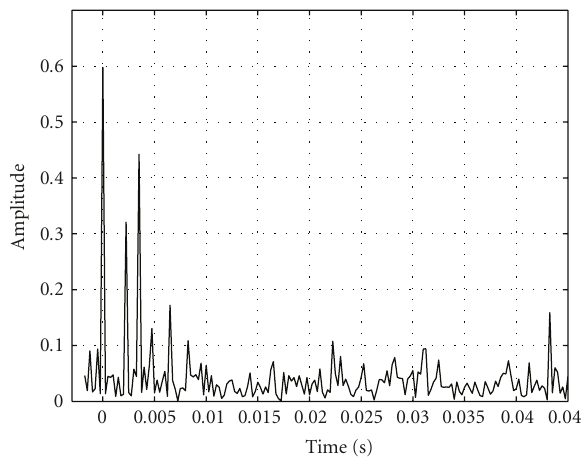
(a) Non − Gray mapped constella- (b) Gray mapped constellation tion Figure 4: QPSK constellation mappings.